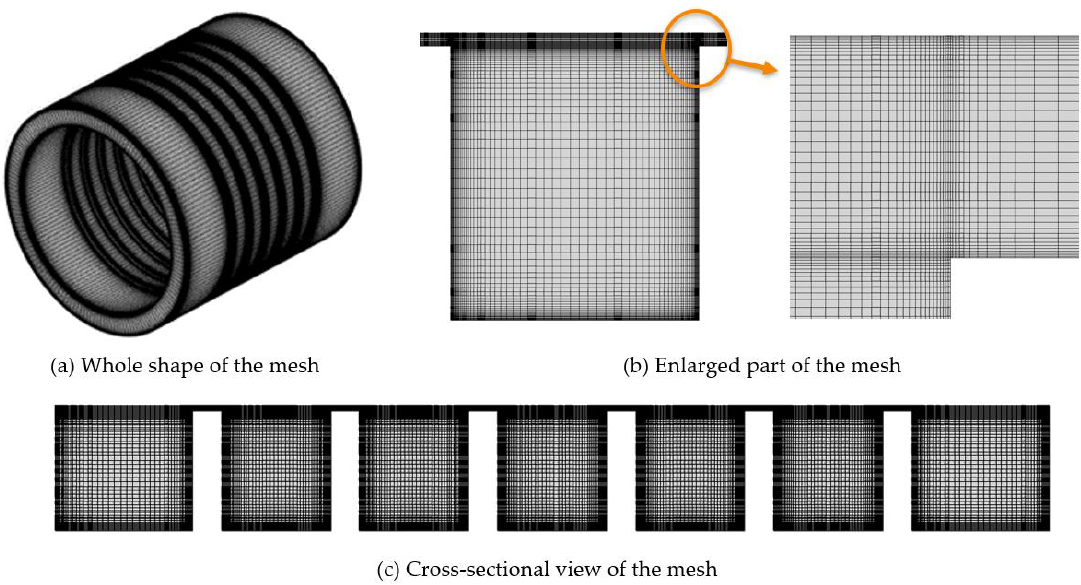
Figure 4. Baseline mesh of the labyrinth seal ( a ) whole shape of the mesh, ( b ) enlarged part of the mesh, and ( c ) cross- sectional view of the mesh.